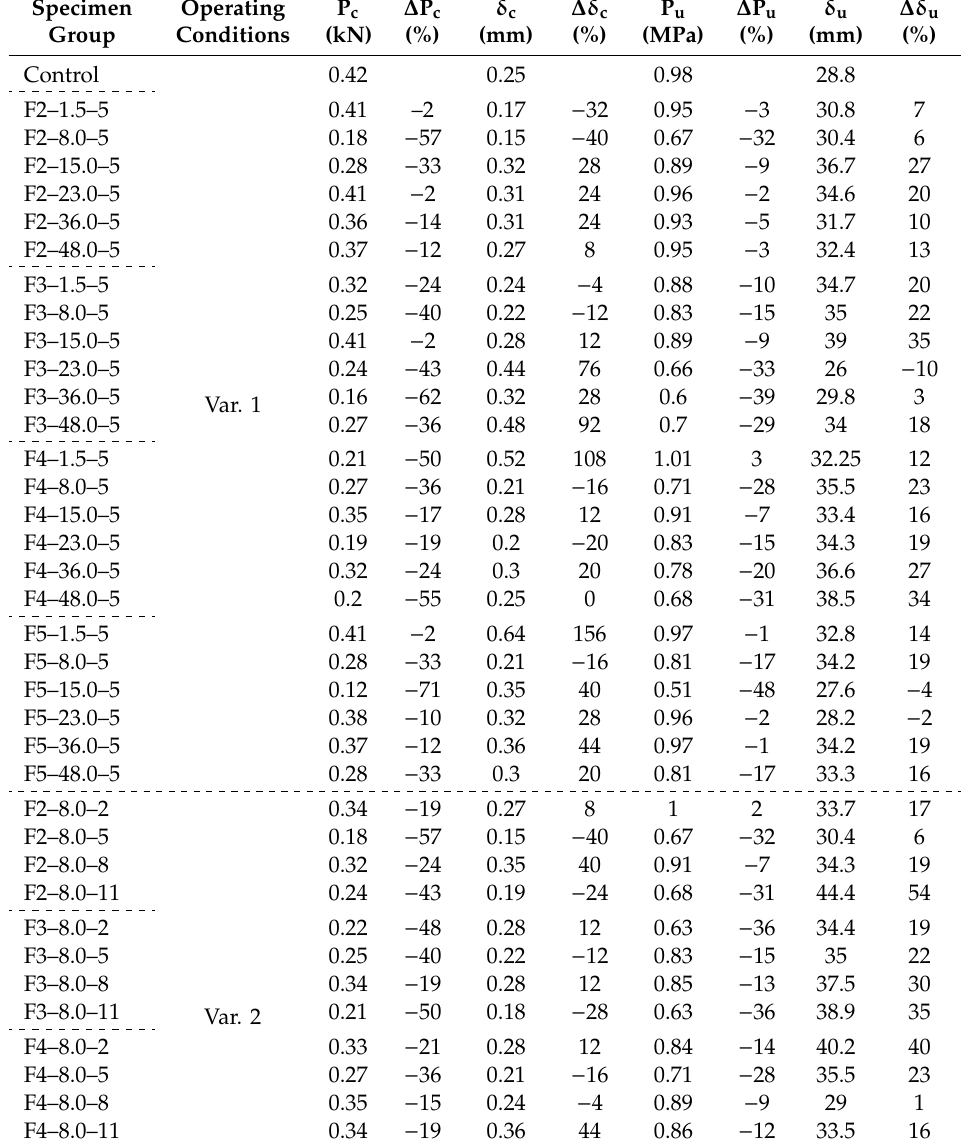
Table 9. Winsorized means of the cracking load (P c ), mid-span deflection ( δ c ), extreme flexural load (P u ), and mid-span deflection ( δ u ) of all 37 groups of polyvinyl alcohol fiber reinforced engineering cementitious composite (PVA-ECC)